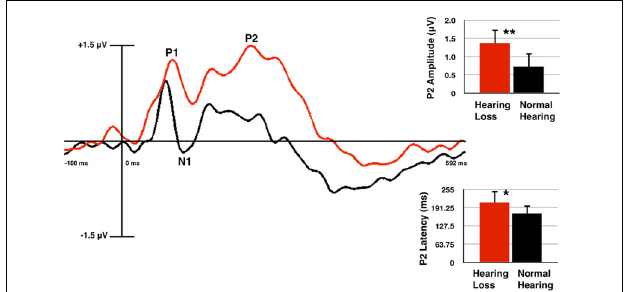
FIGURE 2 | Grand averaged cortical auditory evoked potentials (CAEPs) from the frontal region of interest (ROI) for the normal hearing (NH, in black) and hearing loss (HL, in red) groups. P2 amplitude is significantly higher and P2 latency is significantly longer in the HL group as shown in the waveform and mean amplitude bar graphs. Two asterisks indicate significance at p < 0 . 01, one asterisk indicates significance at p < 0 . 05. Vertical bars on the graph show standard